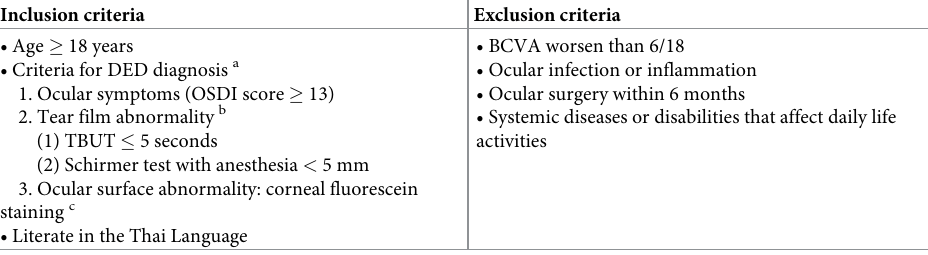
Table 1. Participant selection